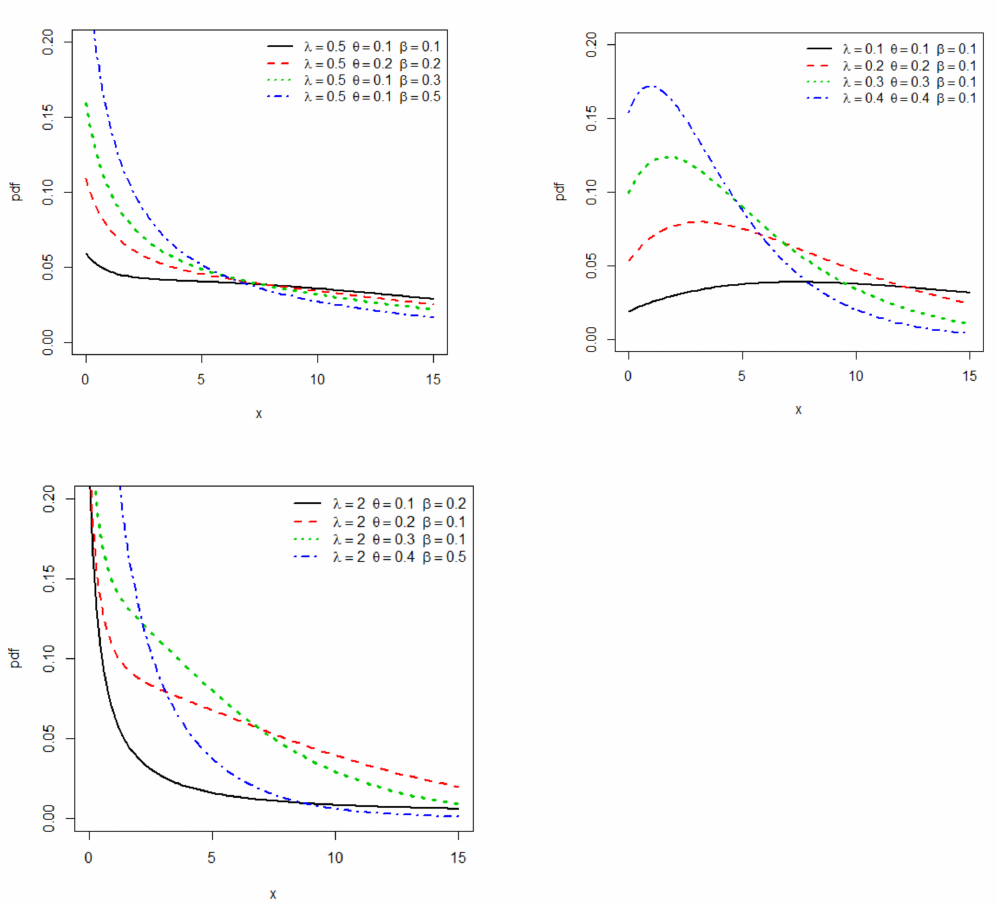
Figure 1. Possible figures of the minLLx pdf for parameter values chosen at